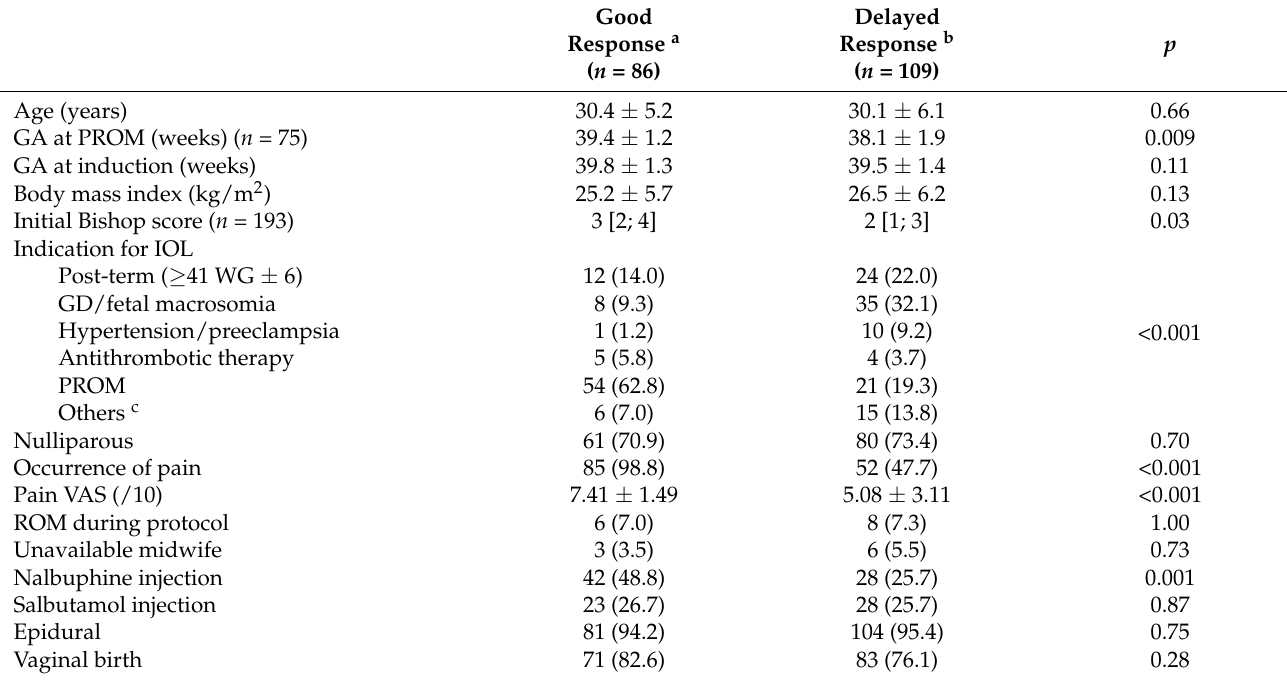
Table 3. Factors associated with the response to the protocol.